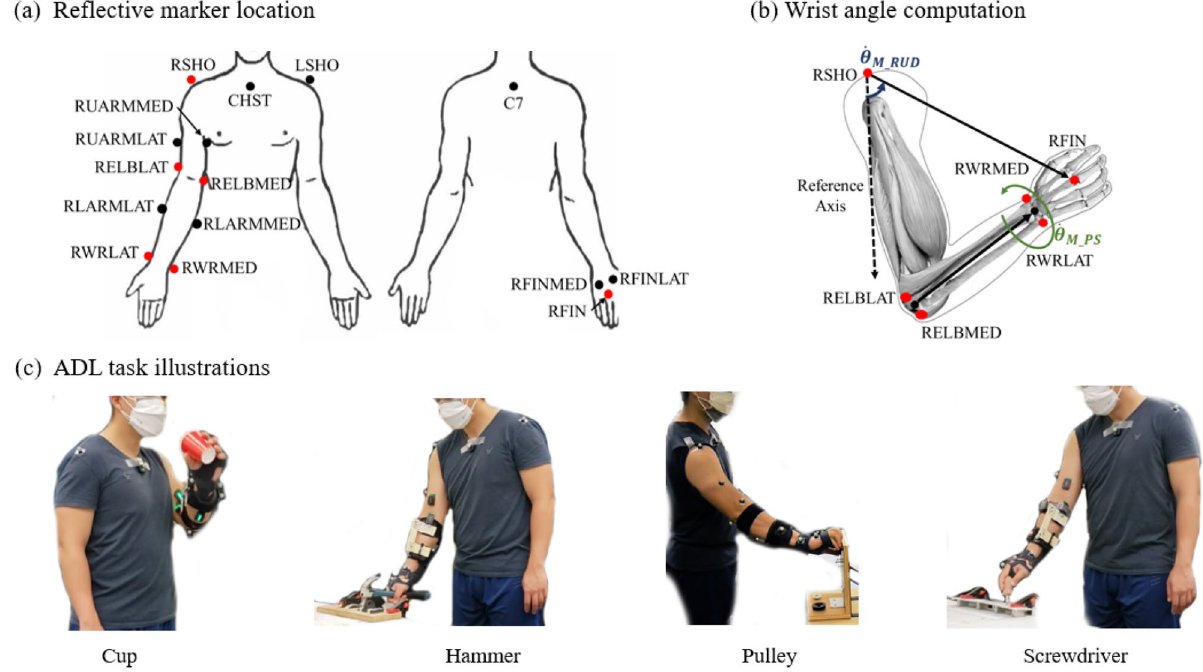
Figure 6. (a) Location of reflective markers attached on the upper limb during the experiment. (b) Illustration of basis vectors used for computation of angular velocity for radial/ulnar deviation and pronation/supination of the wrist. (c) A participant performing four different ADL tasks with the wrist